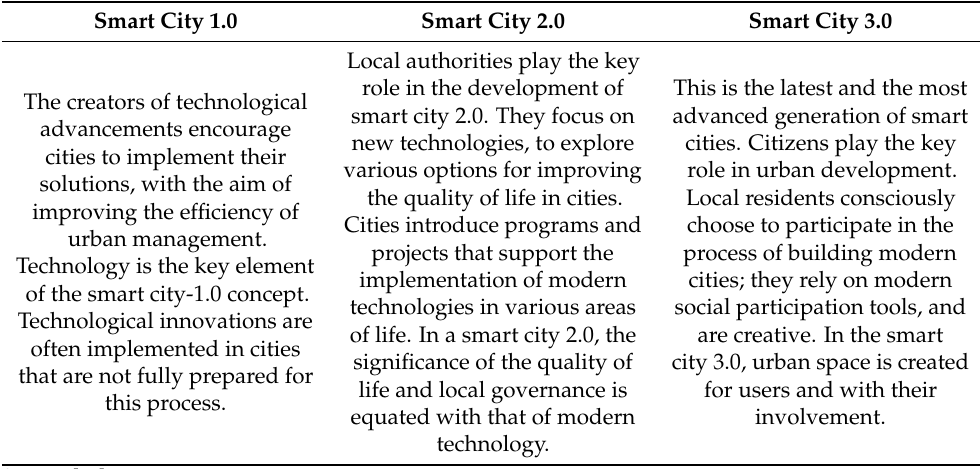
Table 1. The three generations of smart